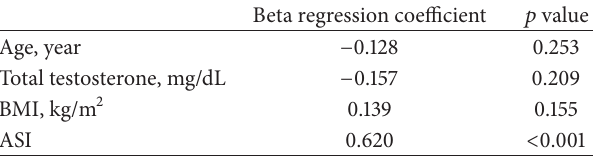
Table 4: Independent association between Δ IIEF-5 and the study parameters by multiple linear regression analysis was shown ( 𝑟 2 = 0.511 , 𝑝 < 0.001